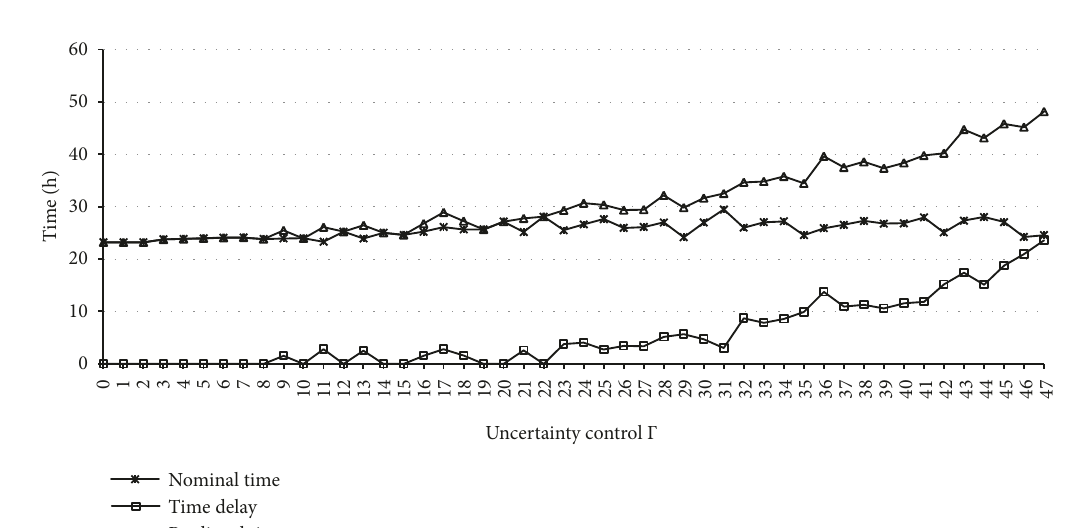
Figure 14: The comparison of convergence procedure based on two genetic algorithms.